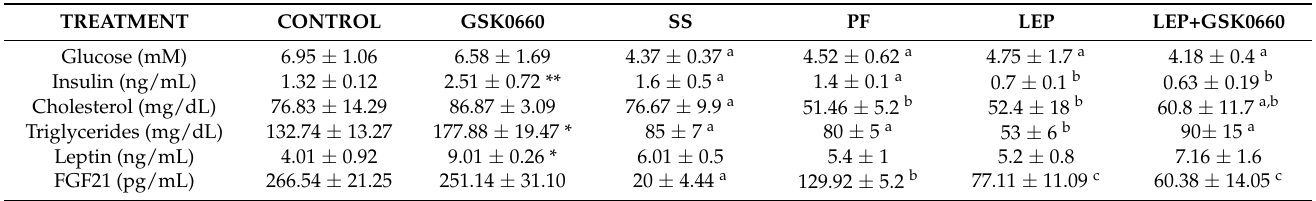
Table 1. Effects of GSK0660 and ICV leptin administration on serum metabolites and hormone levels of the animals.